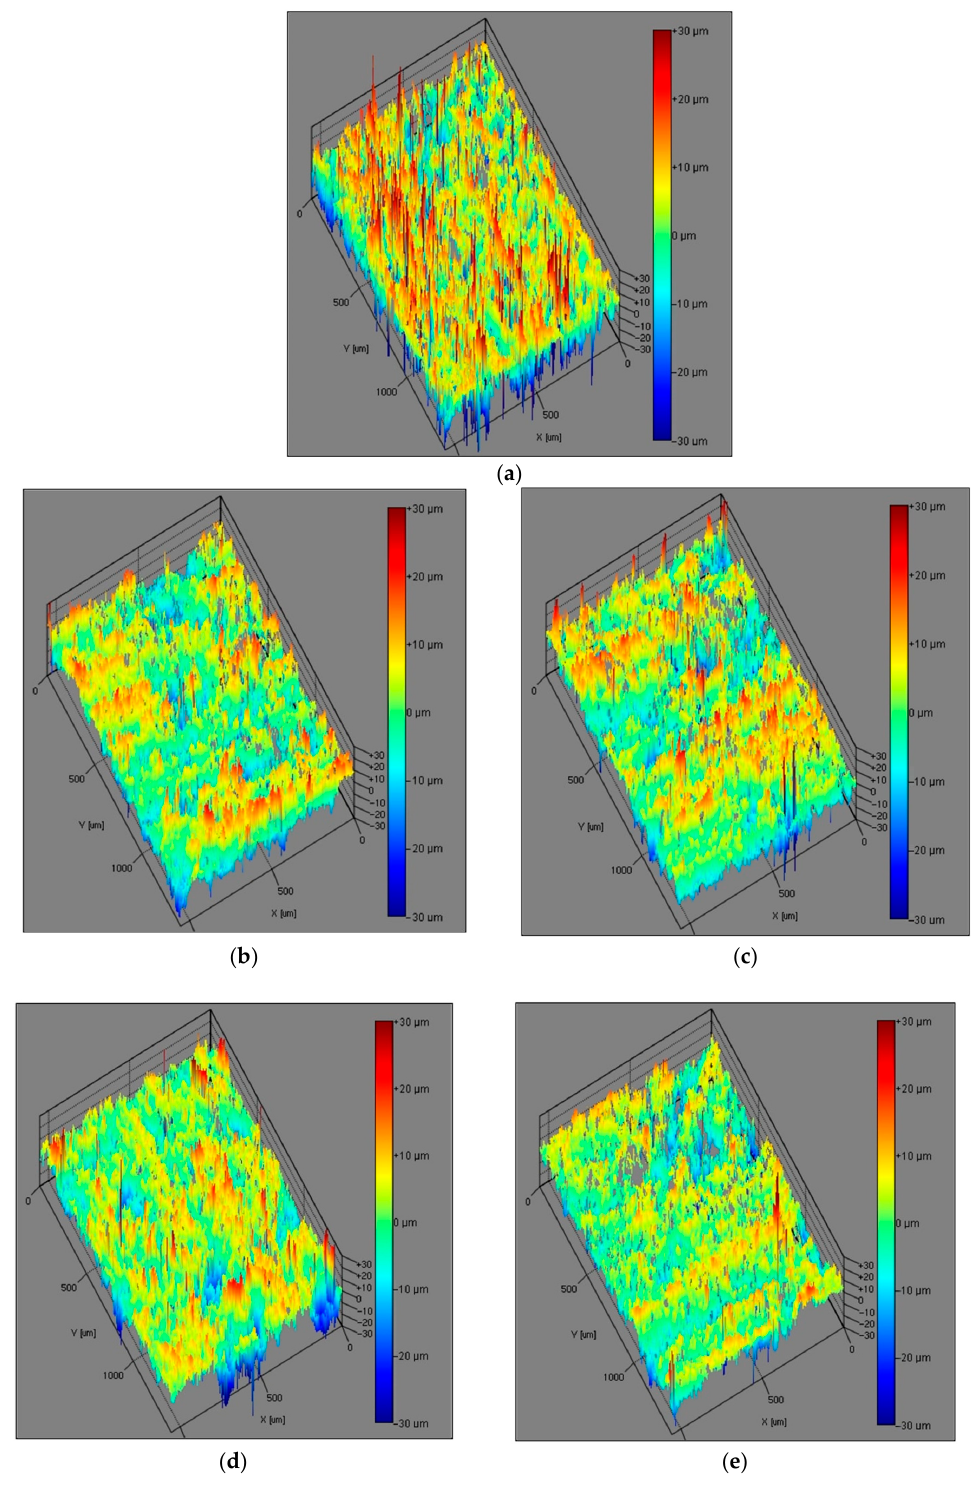
Figure 6. Surface topography of the board C ( a ) before sanding ( b ) sanding program P150, feeding speed 25 m/min ( c ) sanding program P150, feeding speed 50 m/min ( d ) sanding program P150/P220, feeding speed 25 m/min ( e ) sanding program P150/P220, feeding speed 50 m/min.